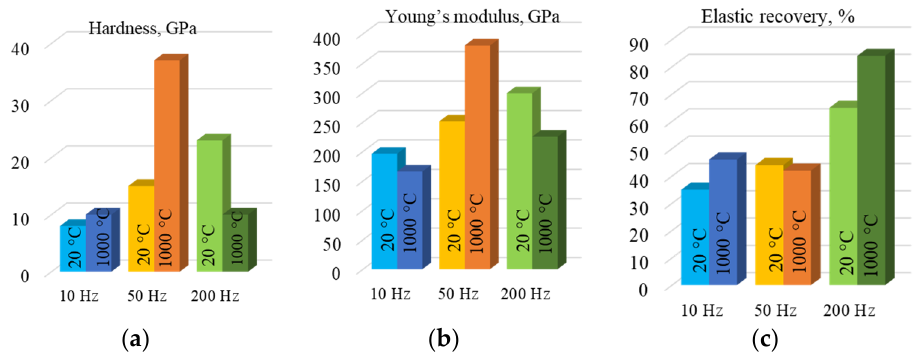
Figure 10. Hardness ( a ), Young’s modulus ( b ), and elastic recovery ( c ) of Mo ‐ Zr ‐ Si ‐ B coatings in the as ‐ deposited state and after vacuum annealing at 1000 °C.